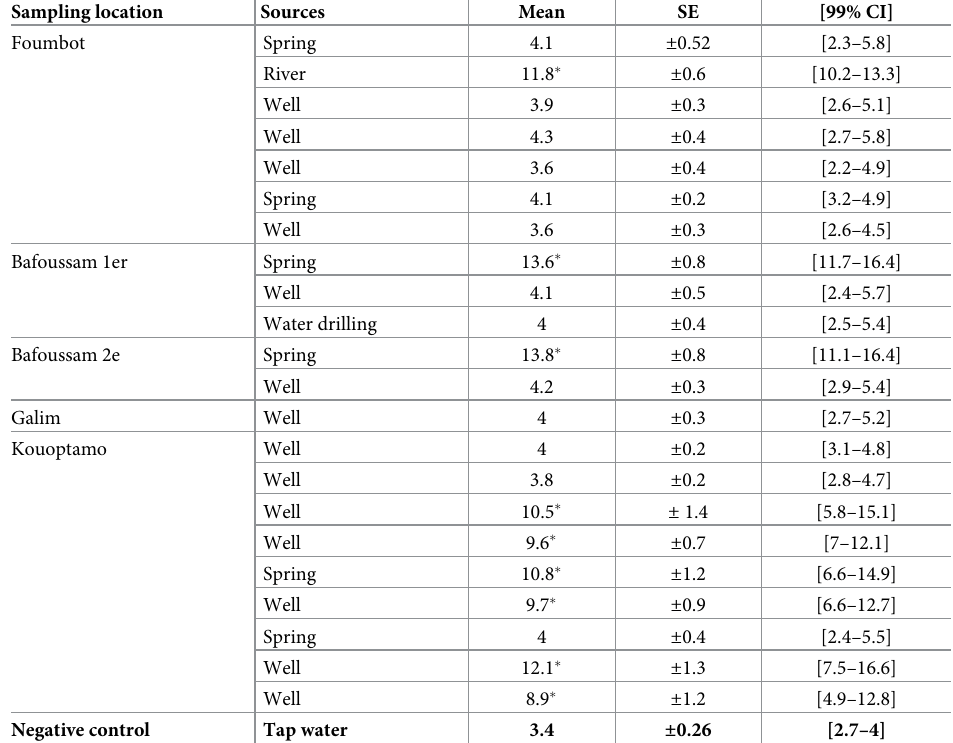
Table 4. Mean per 5000 cells ± Std. Err. of MN frequency in root tips of Vicia faba exposed to water samples, West region, Cameroon, 2018. Sampling